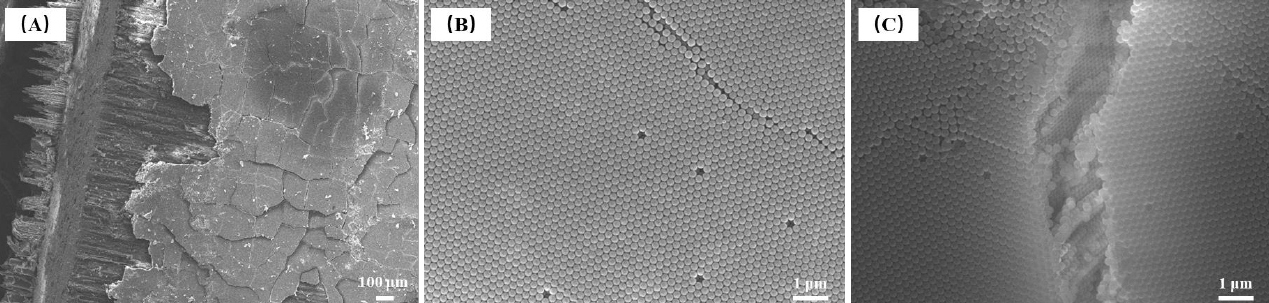
Figure 20. Top-down FE-SEM images of photonic crystals formed by the self-assembly of P(St-AA) colloidal microspheres on wood surfaces: ( A ) low-magnification view; ( B ) high-magnification view; ( C ) crack in the coating.